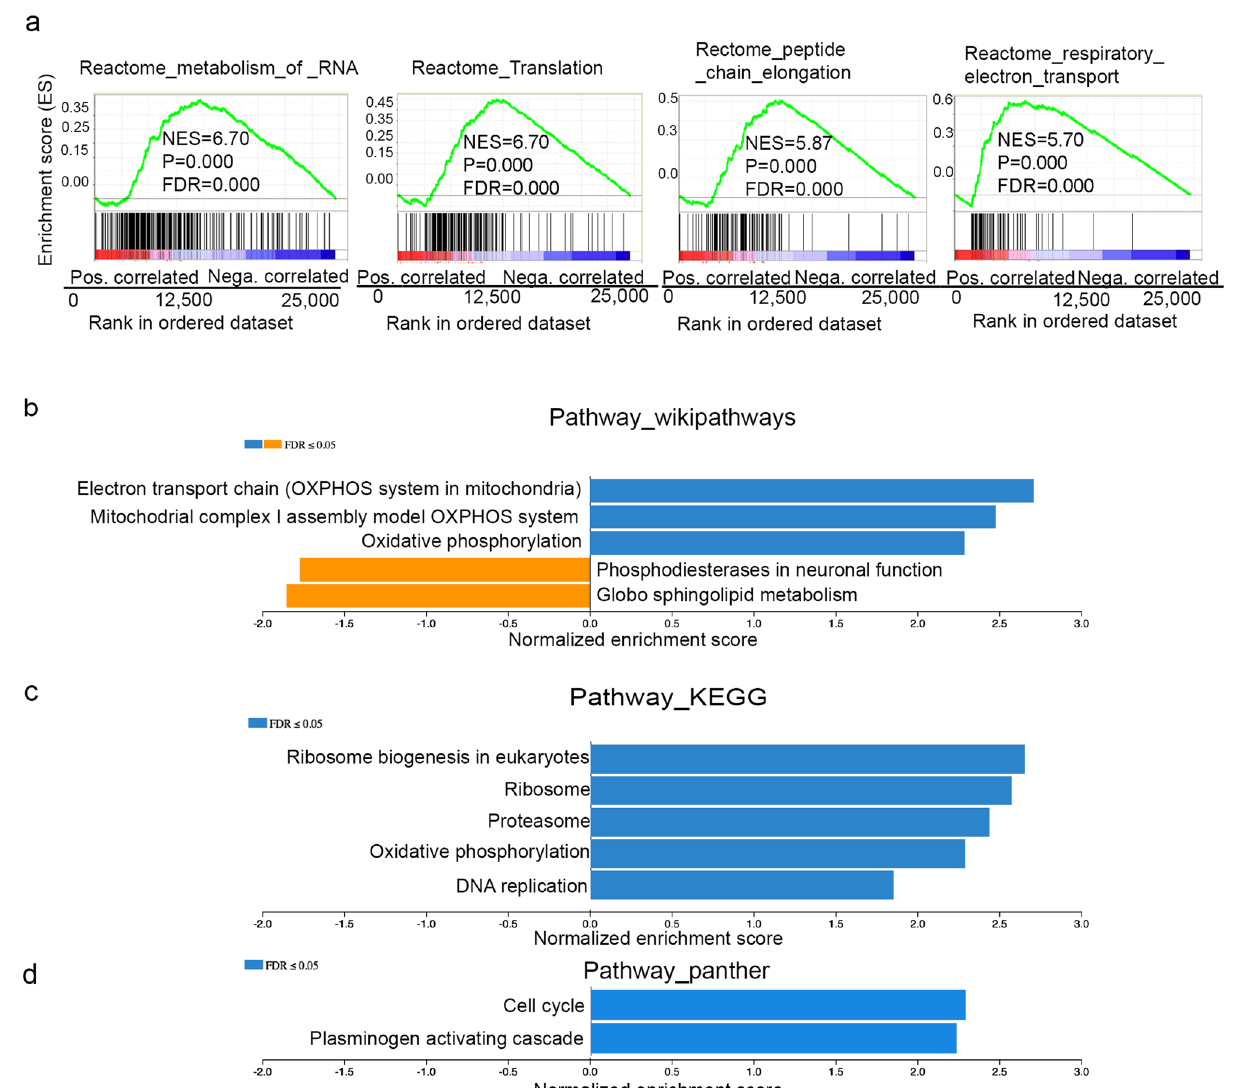
Figure 7. Reactomes and pathways enrichments for OLFM4 -knockout GFP reporter RWPE1 cells. ( a ) Enrichment of reactomes in OLFM4 -knockout GFP reporter RWPE1 cells. ( b ) Bar graph presents upregulated (blue; FDR ≤ 0.05) and downregulated (orange; FDR ≤ 0.05) pathways from Wikipathways. ( c ) Bar graph presents upregulated (blue; FDR ≤ 0.05) pathways from Pathway_KEGG. ( d ) Bar graph presents upregulated (blue; FDR ≤ 0.05) pathways from